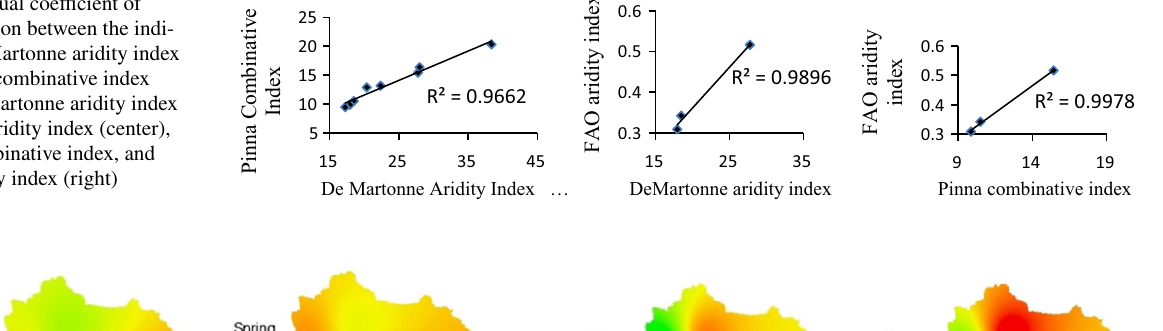
510152025 R² = 0.9662